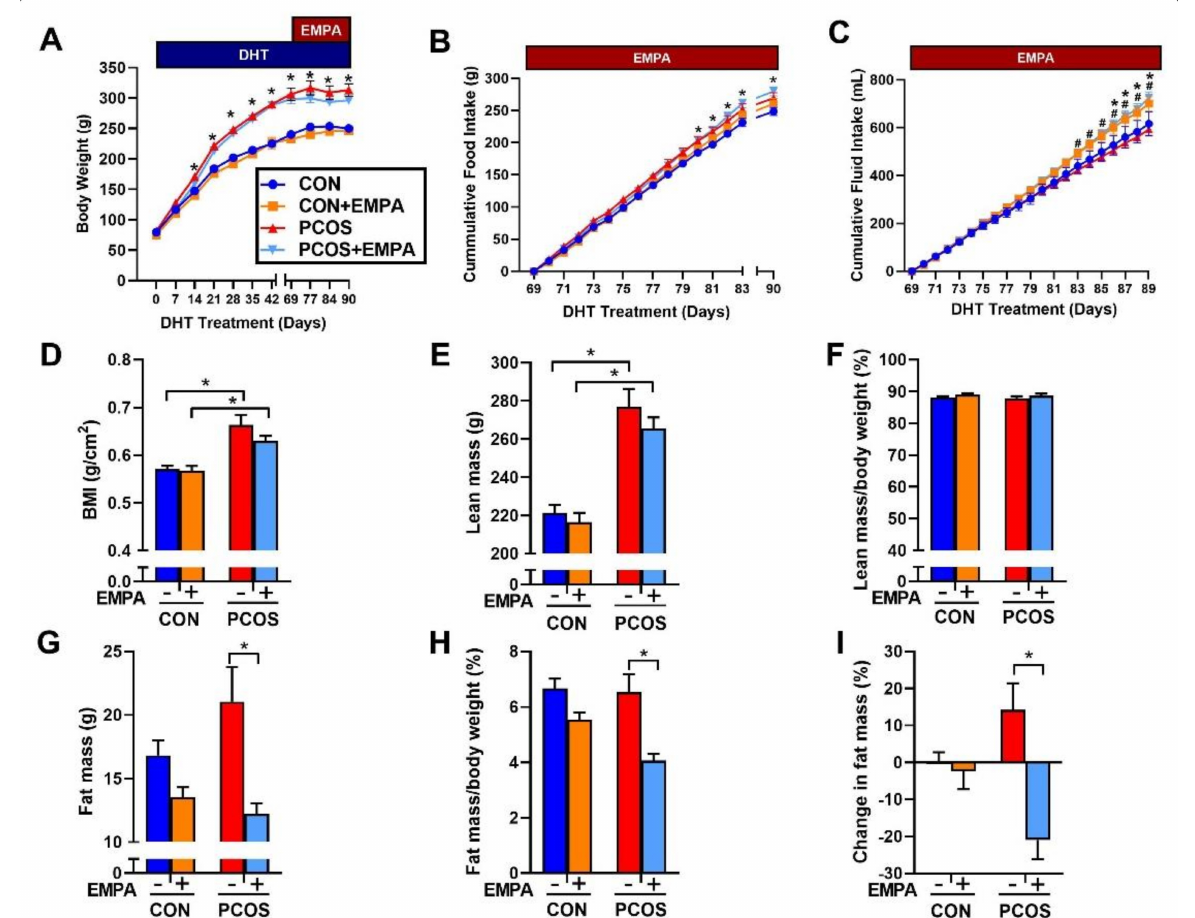
Figure 2. Effect of Empagliflozin (EMPA) on anthropomorphic measures in PCOS. Effect of EMPA on ( A ) BW, ( B ) cumulative food intake, ( C ) cumulative fluid intake, ( D ) body mass index (BMI), ( E ) total lean mass, ( F ) lean mass corrected by body weight (BW), ( G ) total fat mass, ( H ) fat mass corrected by BW, and ( I ) percent change in fat mass before and after three weeks of EMPA treatment. Data are expressed as mean ± SEM. Data were analyzed by two-way repeated measures ANOVA followed by Tukey post-hoc tests. Significant interaction was only observed for BW and percent change in fat mass. * p < 0.05 vs. untreated control rats; # p < 0.05 vs. untreated PCOS rats. n = 7–10 per group. CON: Control, CON+EMPA: Control+Empagliflozin, PCOS: Polycystic Ovary Syndrome, PCOS+EMPA: Polycystic Ovary